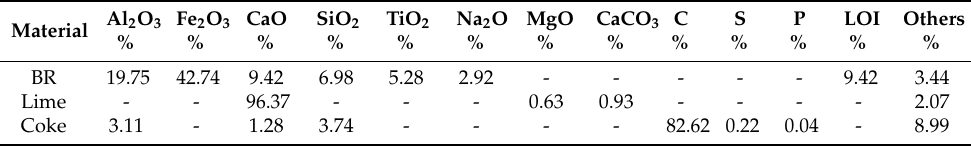
Table 3. Chemical analysis of the materials used in pilot scale pyrometallurgical tests.